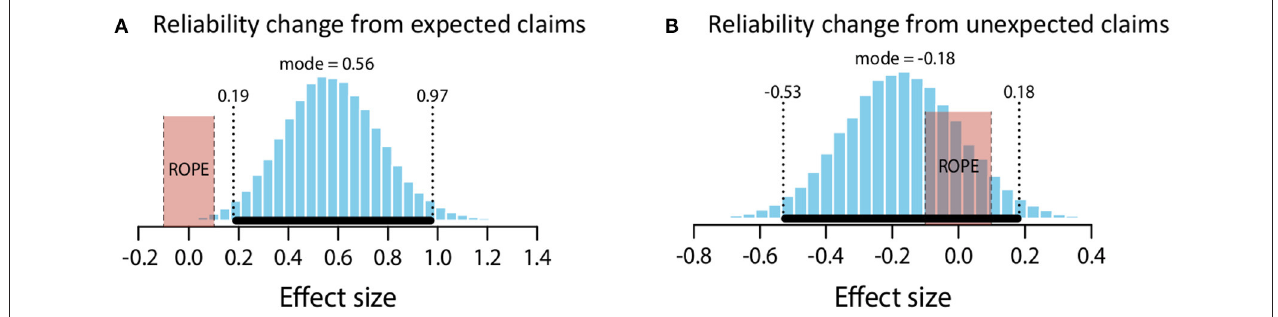
FIGURE 9 | Posterior distributions of effect size for change in perceived reliability from expected claims (A) and unexpected claims (B) . ROPE from − 0.1 to 0.1. Black bar represents 95%